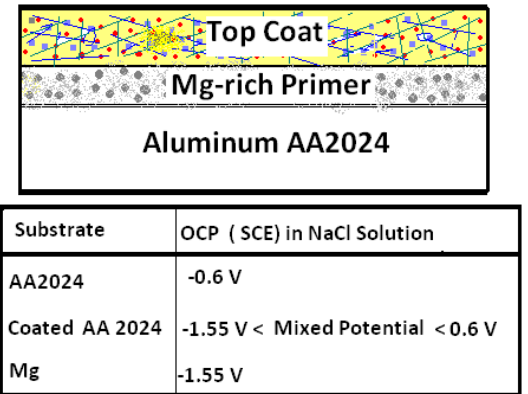
Figure 2. Schematic showing the open circuit potential (OCP) of Mg-rich primer coated AA2024